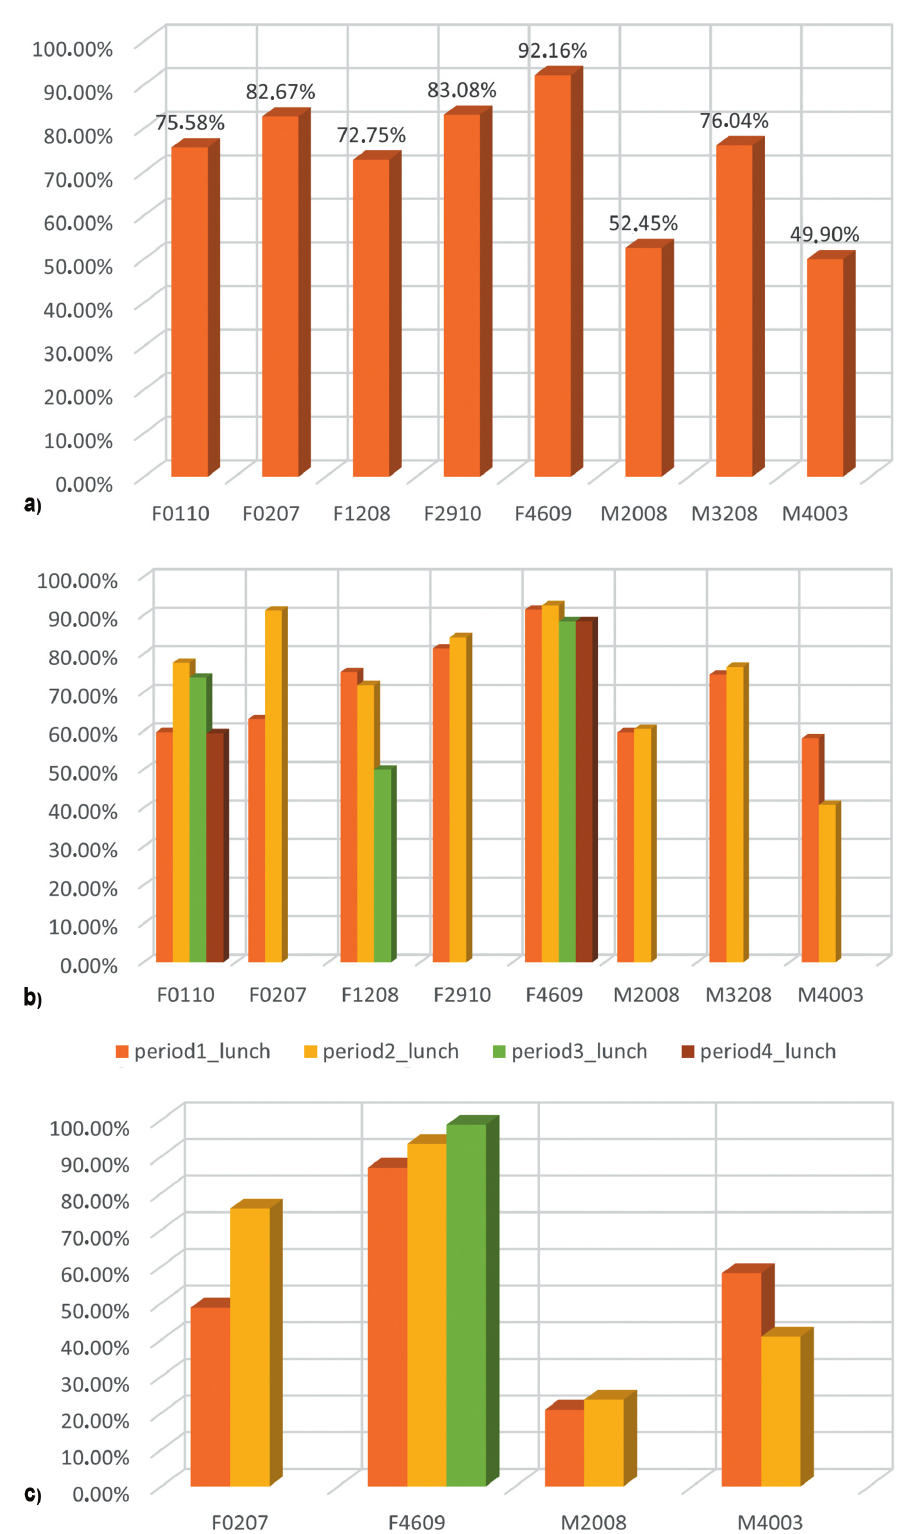
Figure 4. Trends of TIR for each change in the insulin pump and the full period under study for each patient. ( a ) Tir computed for all the 91 days. ( b ) TIR computed in different period during lunch time. ( c ) TIR computed in different period during dinner